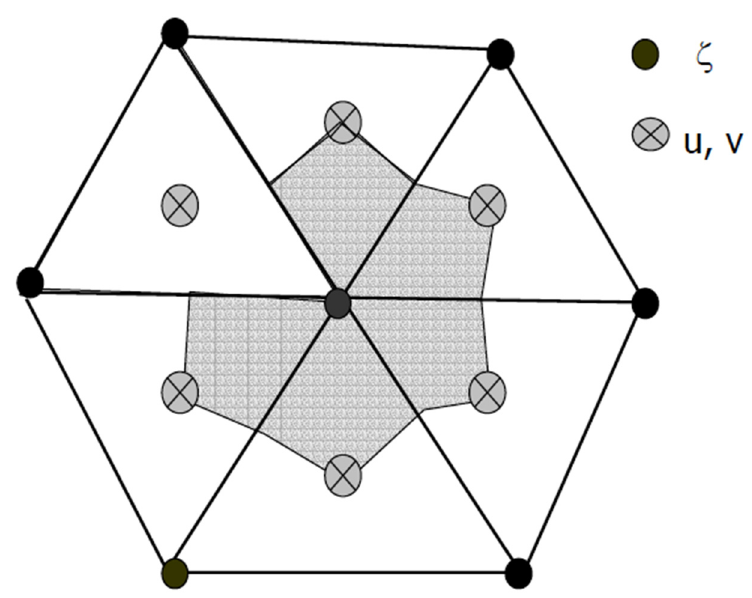
Figure 3. Illustration of dry and wet segments of a tracer control element.